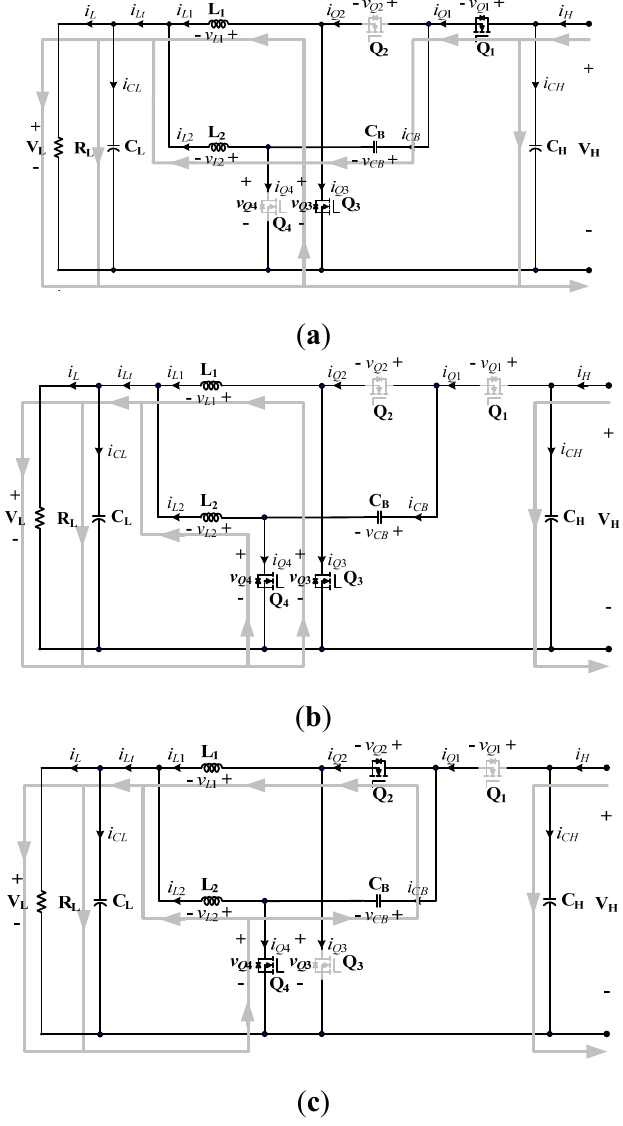
Figure 5. Operating modes of the proposed converter in the charge mode operation. ( a ) Mode 1; ( b ) Mode 2 and Mode 4; and ( c ) Mode